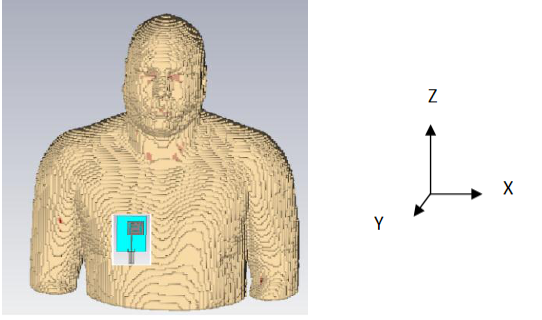
Figure 2. Location and orientation of the dual band PIFA on the human